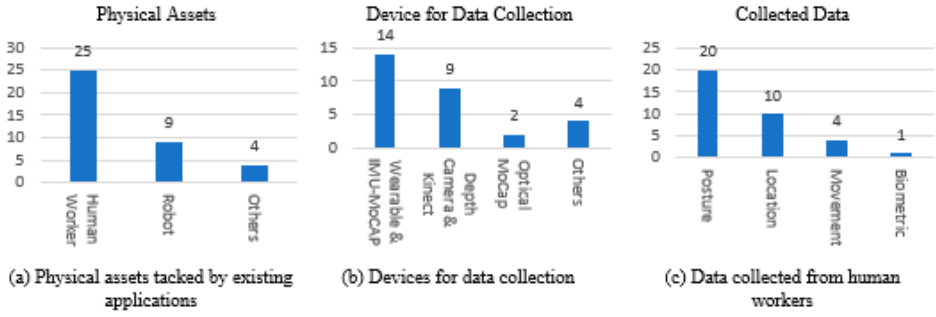
Figure 9. Data collection procedure of existing applications.